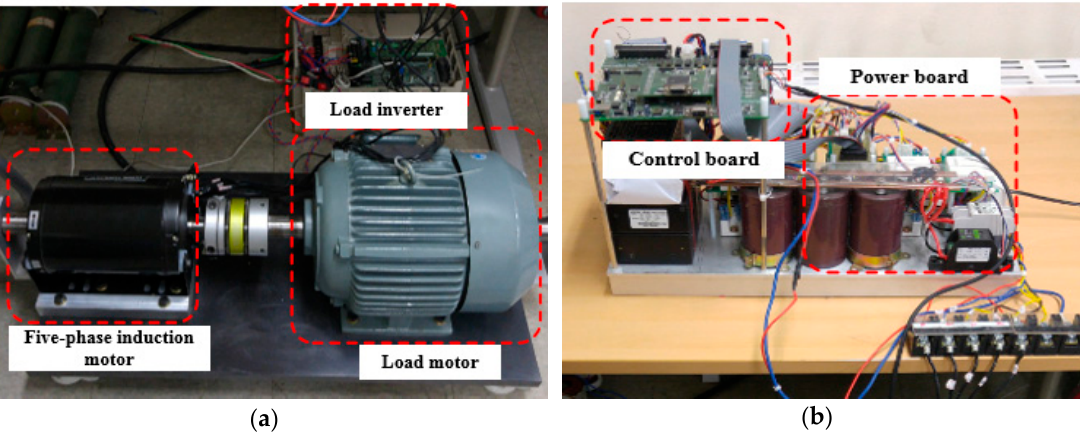
Figure 7. Experimental setup: ( a ) Five ‐ phase IM and load motor; ( b ) Control board and power board.